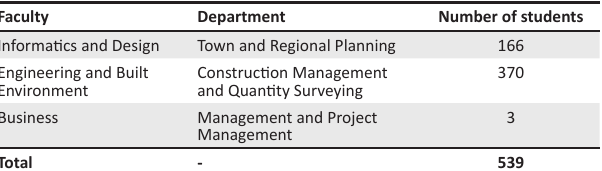
TABLE 2: A summary of expectations before and after transdisciplinary